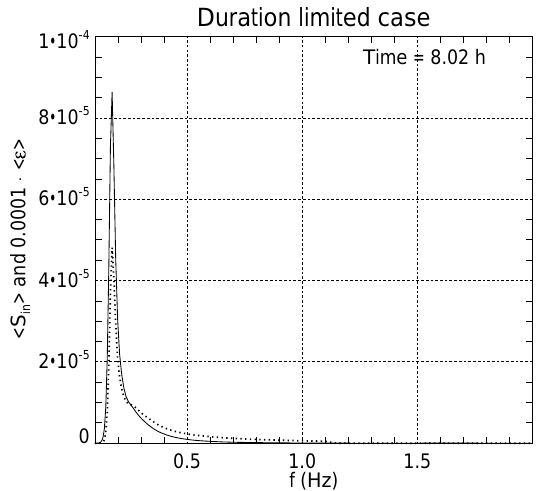
Figure 9. Typical, angle averaged, wind input function density R γ(ω,θ)ε(ω,θ) d θ (dotted line) and angle averaged (cid:104) S (cid:105) = 1 in 2 π R ε(ω,θ) d θ (solid line) as the functions of the spectrum (cid:104) ε (cid:105) = 1 2 π frequency f = ω for the wind speed U = 10ms − 1 duration 2 π